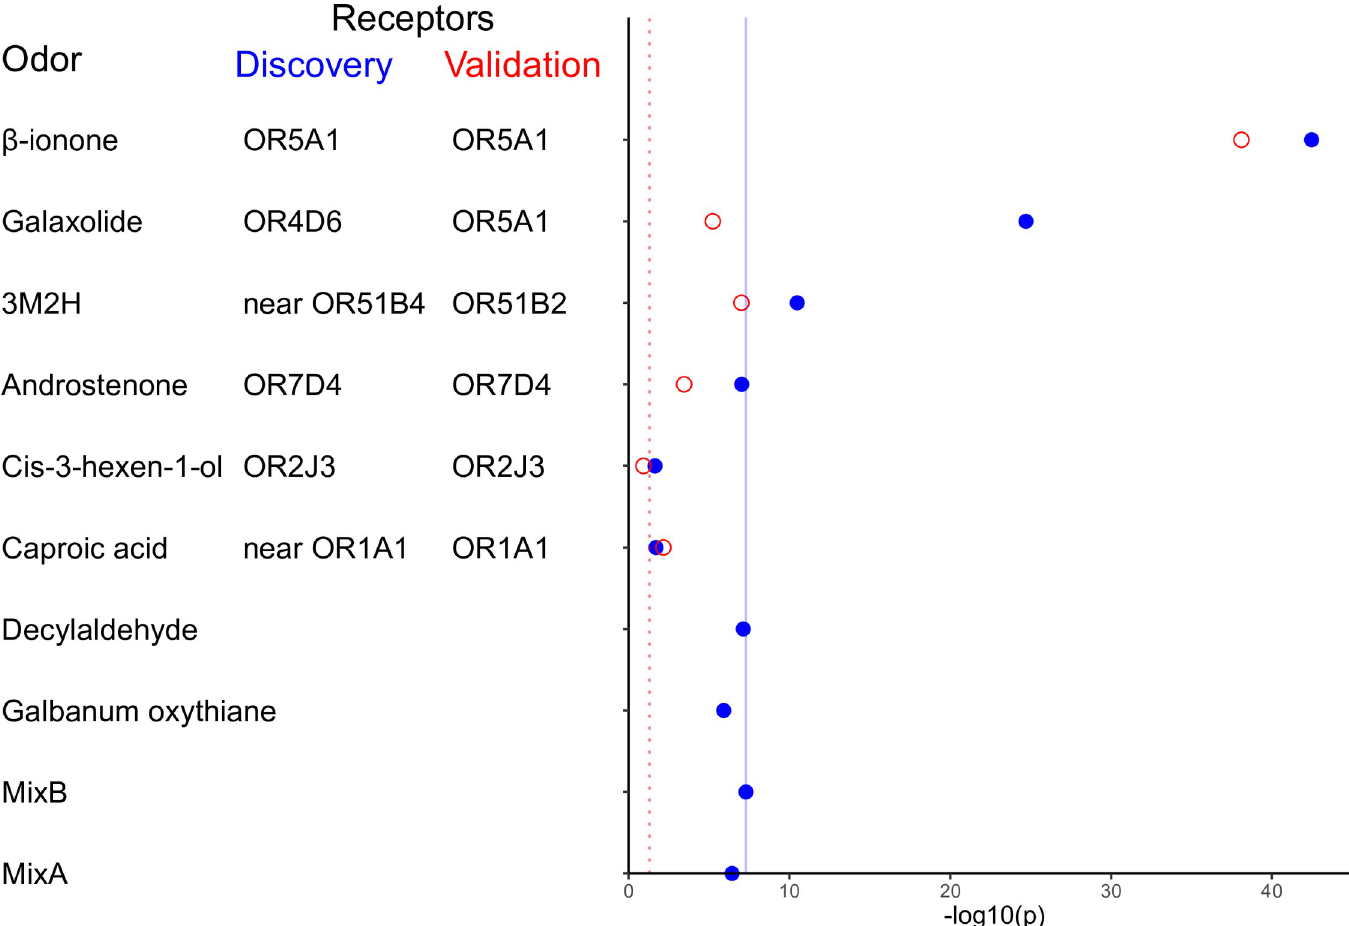
Fig 2. Top associations between genetic variation and odor intensity perception. Each row represents the top SNPs associated with the odor intensity phenotype in the discovery cohort (blue filled circles) and the replication cohort (red open circles). Listed next to each odor is the nearest gene to the top SNP for each cohort. There were two novel associations that reached genome-wide significance in the discovery cohort (p < 2.5x10 -9 , solid blue line): Galaxolide/rs1453541(M263T) and rs1453542 (S151T) (p < 2.4x10 -25 , p < 3.0x10 -25 ) and 3M2H/rs3898917 (p < 1.9x10 -11 ). The discovery study replicated the associations from the literature (p < 0.05, dotted red line) for β -ionone/rs6591536 (D183N) (p < 5.5x10 -42 ), androstenone/rs61729907 (R88W) and rs5020278 (T133M) (in both cases, p < 9.3x10 -8 ), and cis-3-hexen-1-ol/rs28757581 (T113A) (p < 0.02). The discovery cohort was unable to impute the region around OR1A1 for replication of the caproic acid association. Other than β -ionone, no replication odors had associations that reached genome-wide significance. For this set of replication odors ( β -ionone, androstenone, cis-3-hexen-1-ol, and caproic acid), the association shown is the top association from the LD-band surrounding the previously identified SNP. In the validation cohort (open red circles), we tested associations for the significant SNPs and surrounding LD-bands ( ± 200kb) from the discovery study and previous literature. There were four significant associations in the validation study (p < 0.05; red dotted line): β -ionone/rs6591536 (D183N) (p < 7.8x10 -39 ), Galaxolide/rs591536 and rs7941591 (p < 5.8x10 -6 ), 3M2H/rs10837814 (L143F) (p < 9.6x10 -8 ), and androstenone/rs61732668(P79L) (p < 3.5x10 -4 ). The association for caproic acid/rs17762735 (p < 6.9x10 -3 ) is significant, but in the opposite direction predicted by the previous study.